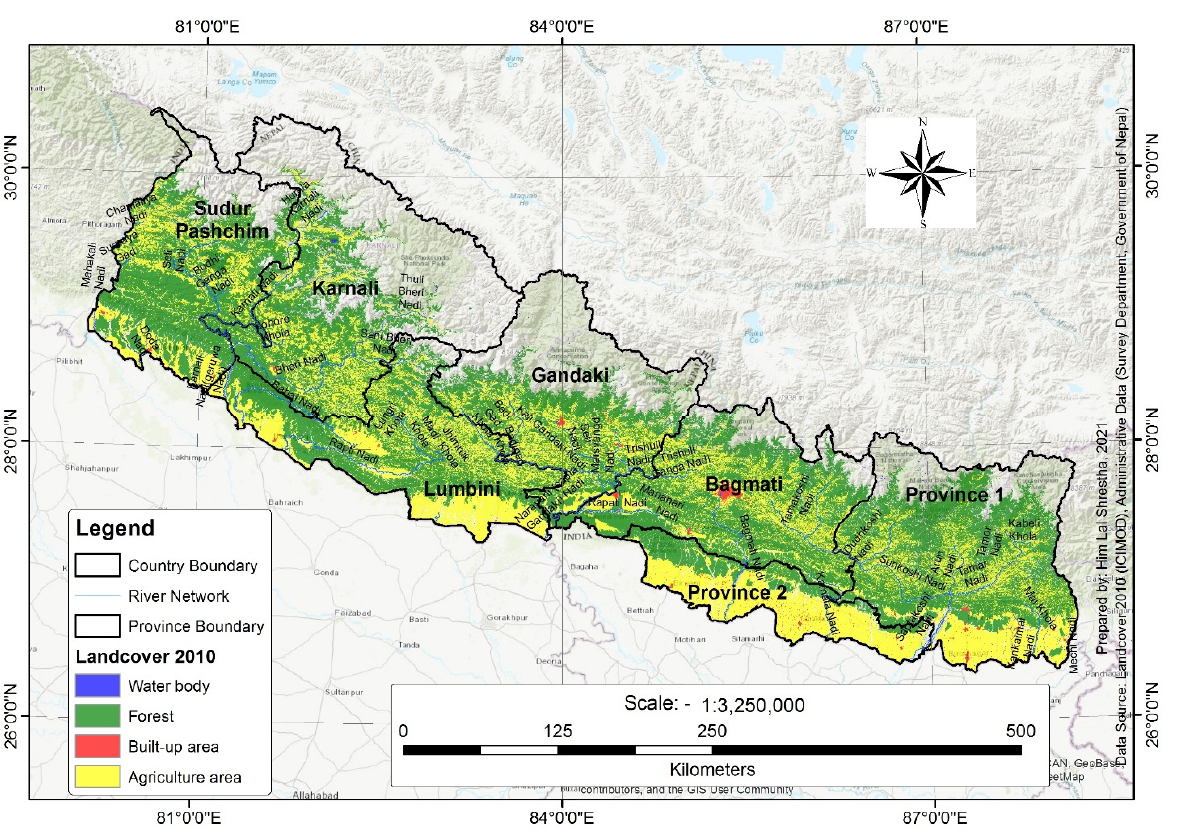
Figure 3. Nepal’s map depicts agricultural and forest mixed landscapes in the mountain. (Source: Department of Land Survey, Nepal Government).